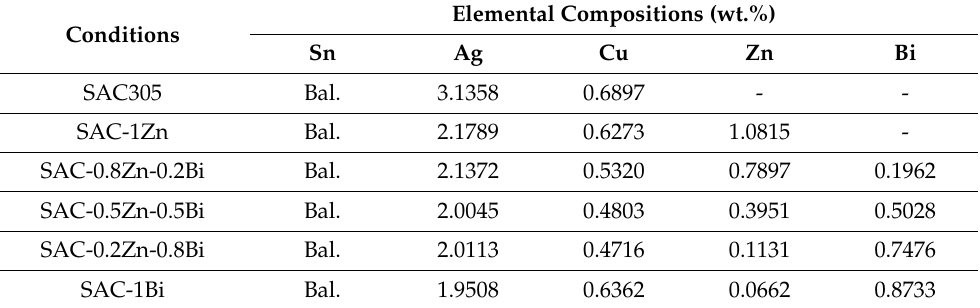
Table 2. XRF results after casting Alloys.